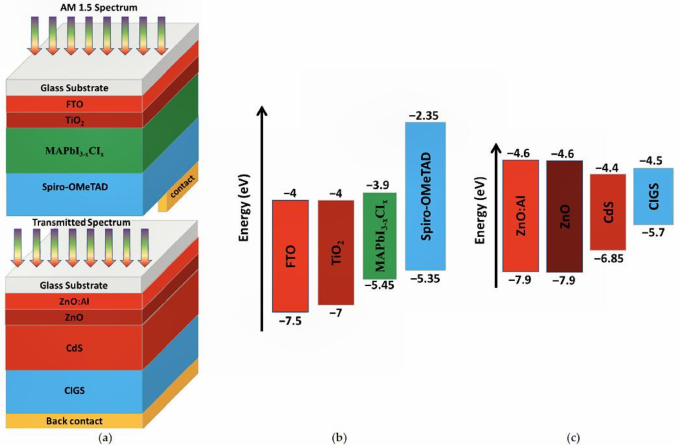
Figure 7. ( a ) Scheme of a perovskite/CIGS tandem device configuration and the corresponding energy levels of the ( b ) upper and ( c ) lower cells. (Figures reprinted from Salah et al. [107], Copyright (2023) with permission of Energies,